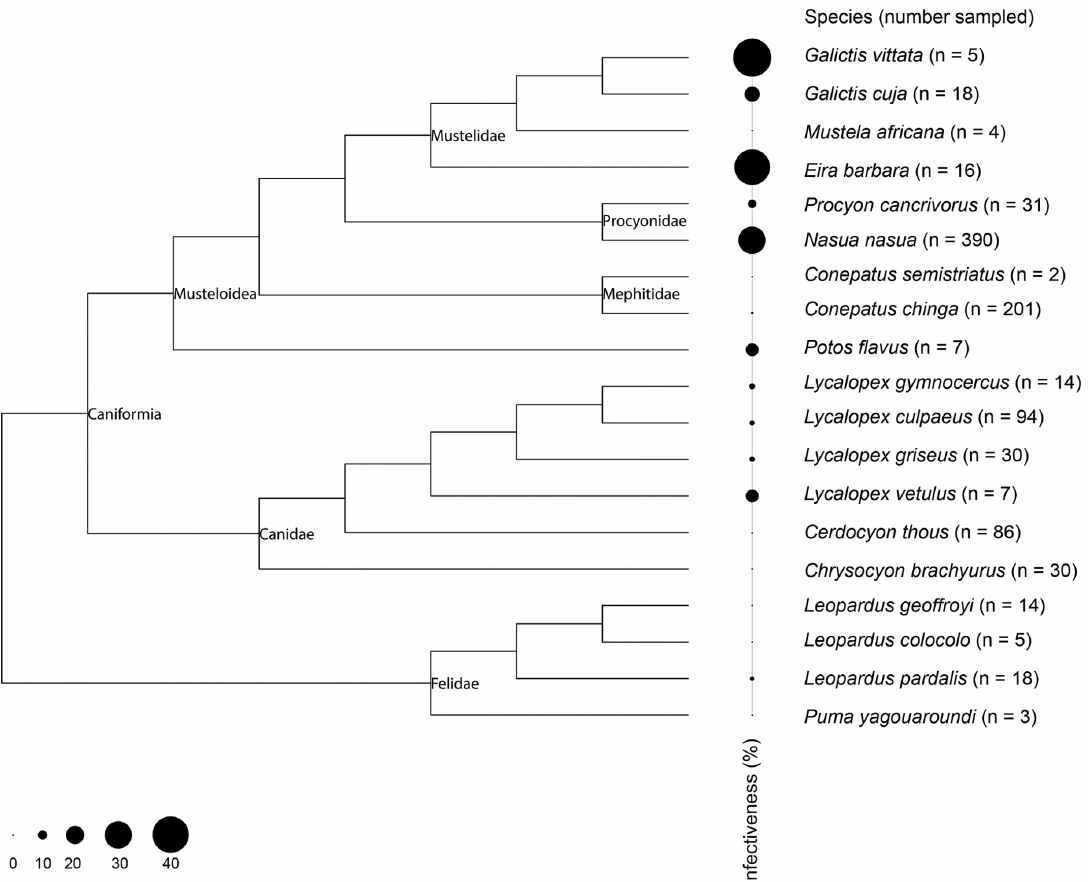
Figure 4. Trypanosomacruzi infectiveness rates in Neotropical carnivore species at the tips of their phylogeny. The size of circles denotes the infectiveness rates, which were determined as the total positive/total examined*100 in hemoculture or xenodiagnosis tests. Phylogenetic topology of Agnarsson et al. [36].